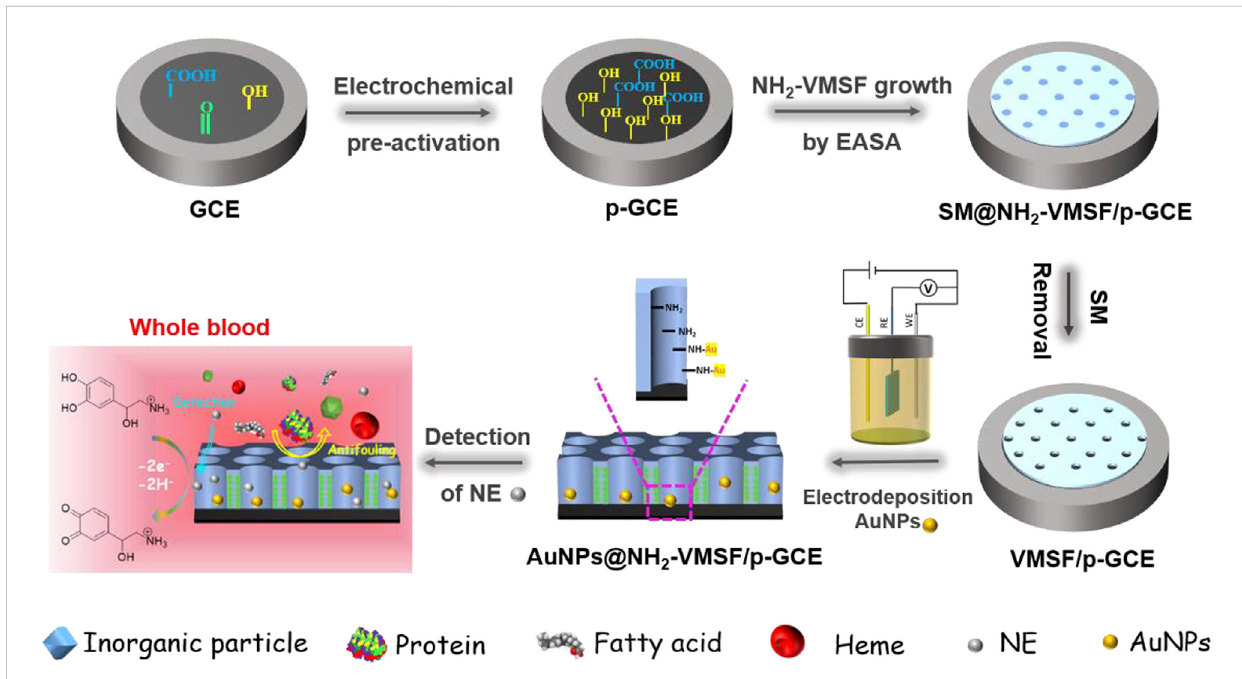
Schematic illustration for fabrication of electrochemical AuNPs/NH 2 -VMSF/p-GCE sensor and the detection of NE in complex sample.